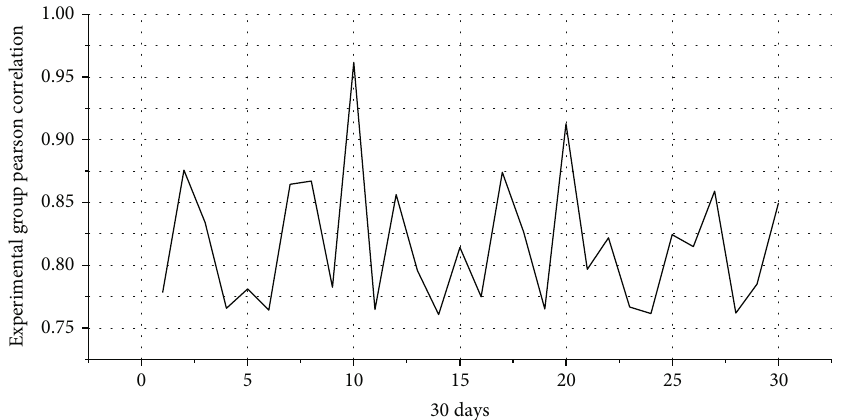
Figure 2: Pearson correlation analysis results of mental health and demographic data in the experimental group.